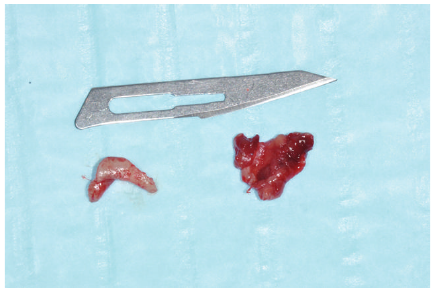
Figure 6: Histologic